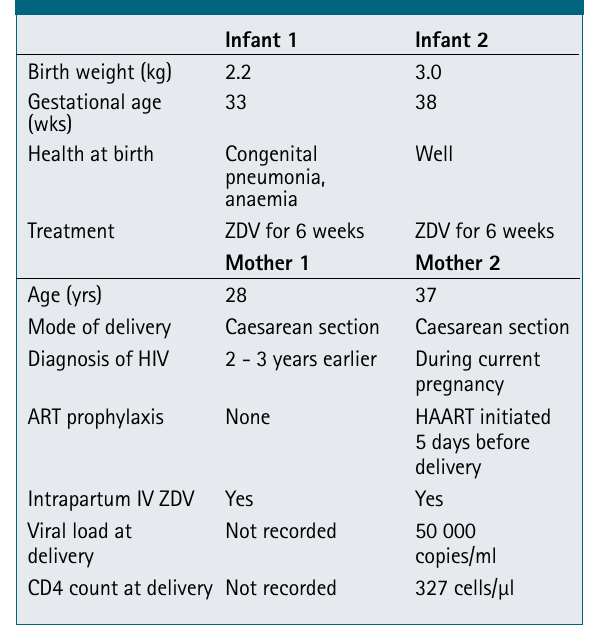
taBle i. DetailS oF tHe 2 HiV-PoSitiVe